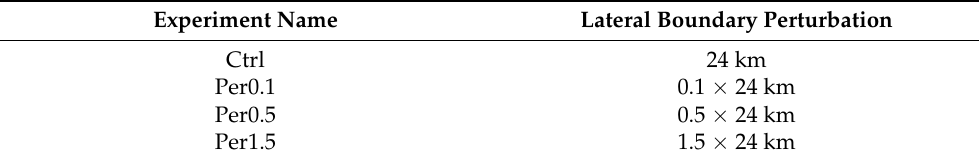
Table 2. Configuration of sensitivity tests for lateral boundary